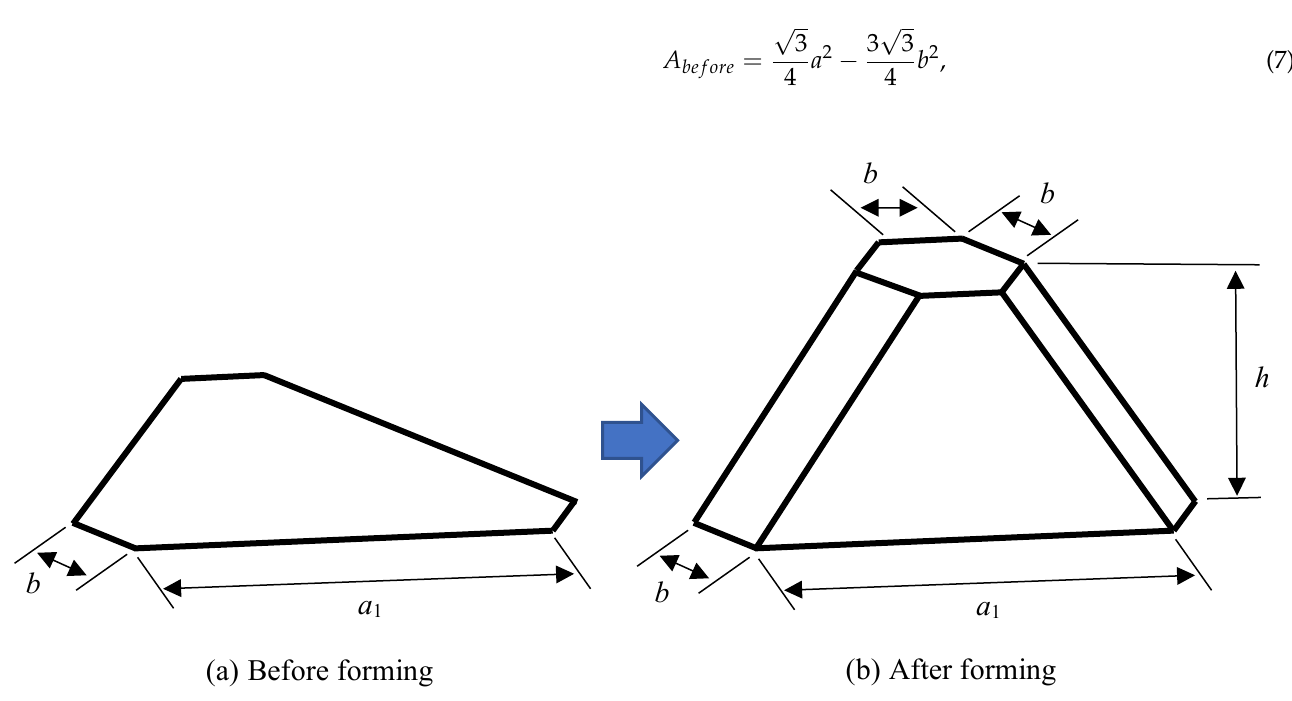
Figure 18. Surface area change when forming a truss core using the deep drawing method.